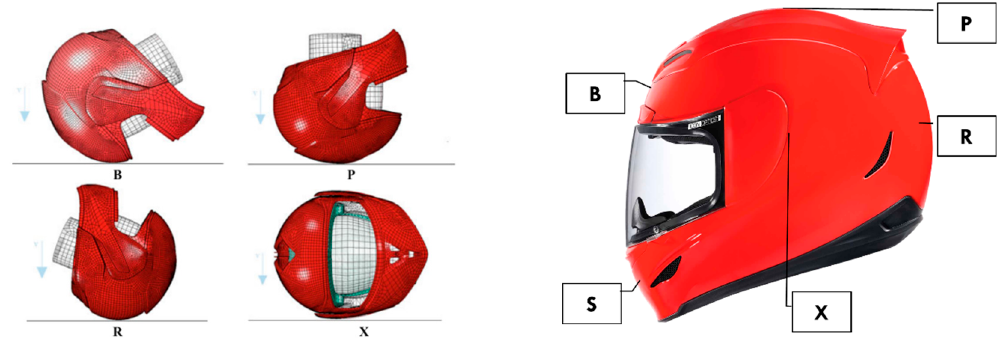
Figure 8. Impact configurations according to ECE R22.05 and marked points for testing.